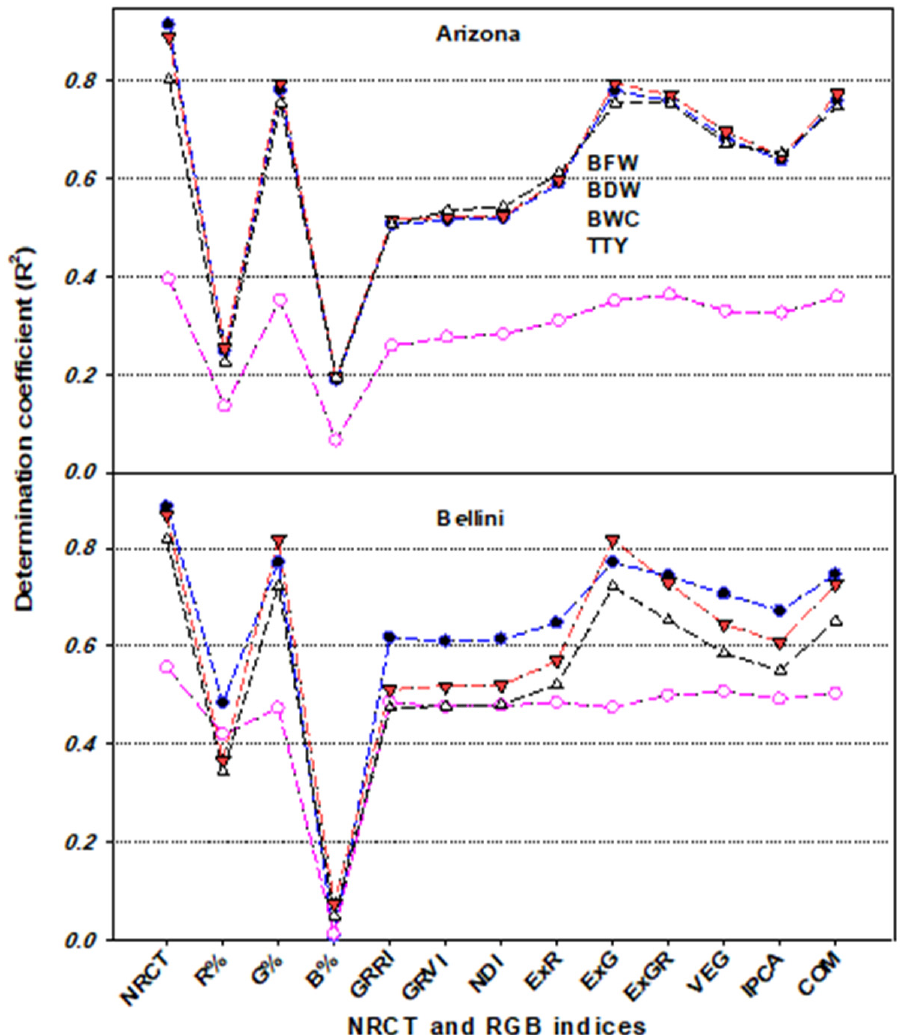
Figure 8. The determination coefficients of relationships between the NRCT and twelve RGB imagery